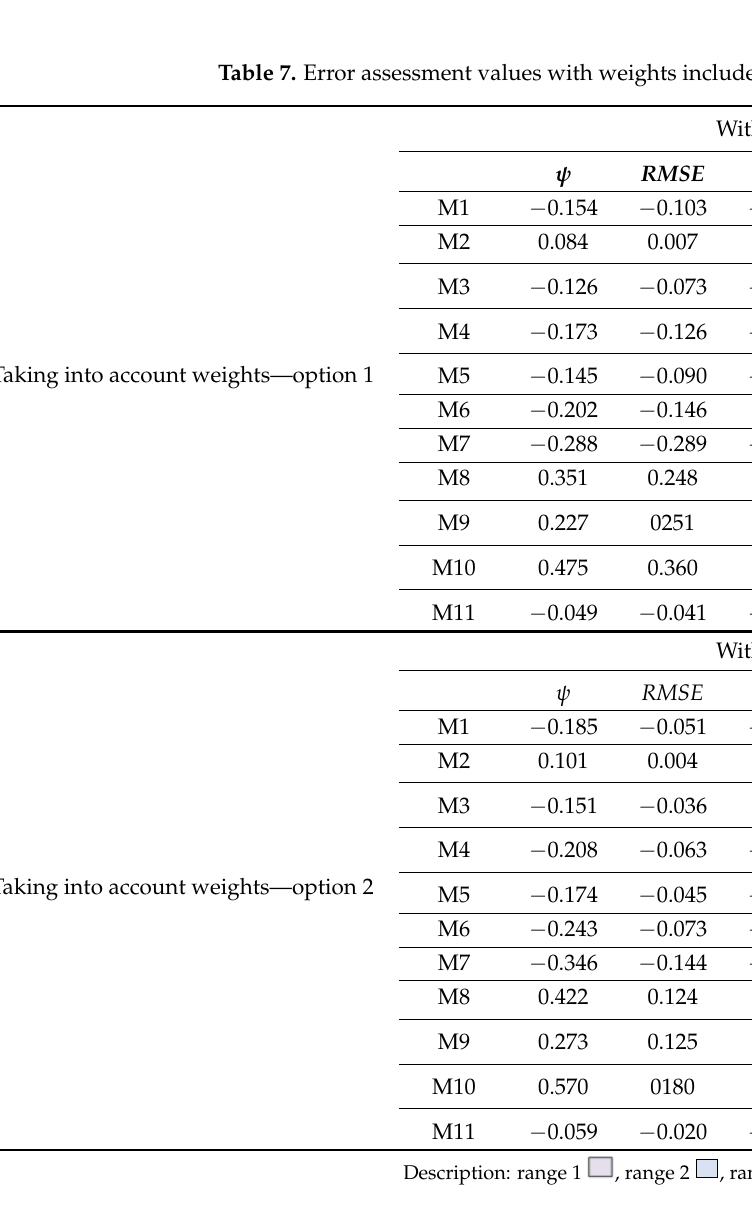
Table 7. Error assessment values with weights included—Option 1 and Option 2.